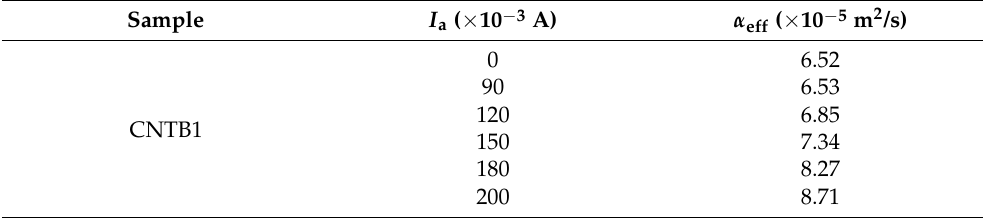
Table 1. Partial experimental results of CNTB1 during current